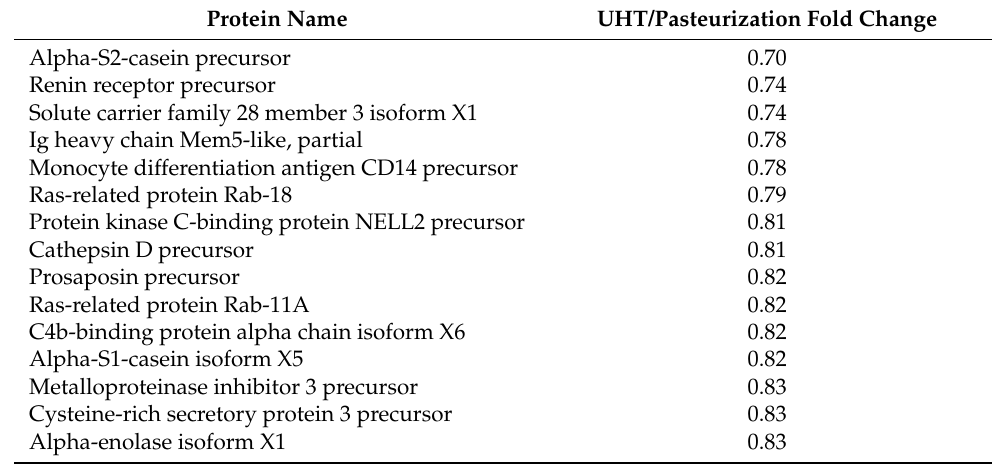
Table 2. Fifteen heat-sensitive proteins identified after UHT thermal